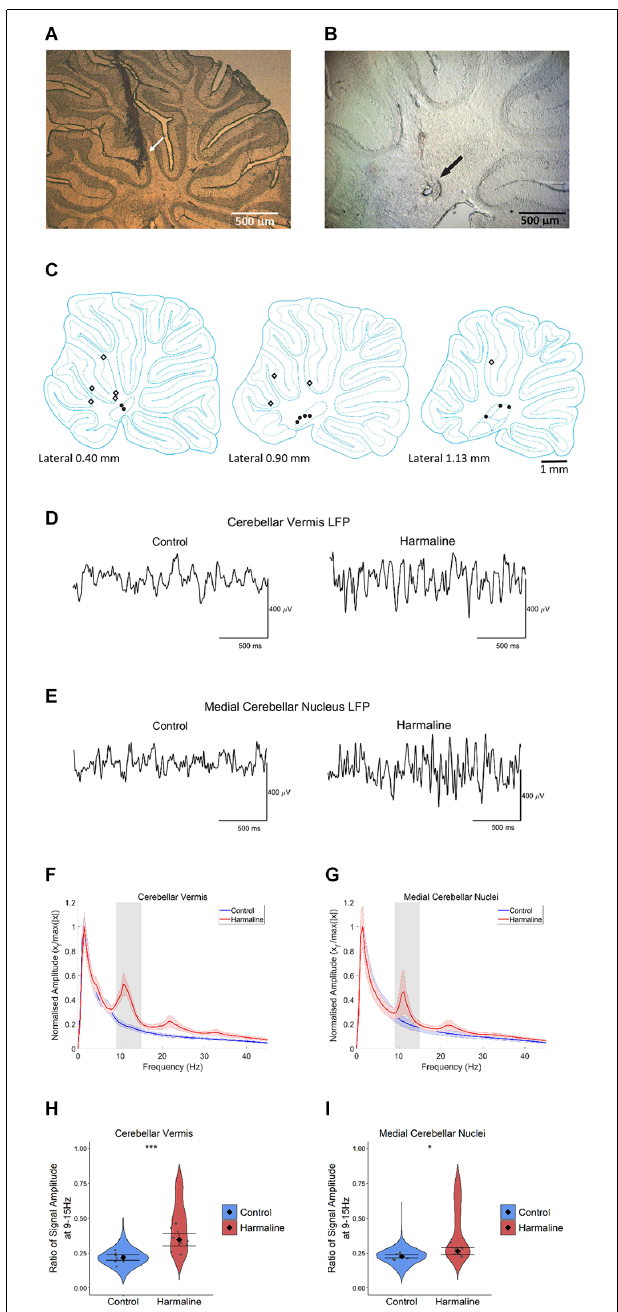
FIGURE 2 | Harmaline increases oscillatory activity in the cerebellum at the tremor frequency. (A,B) Examples of sagittal cerebellar sections with tetrode tracts in the (A) cerebellar vermis and (B) medial cerebellar nuclei from two different rats. Arrows indicate the approximate positions of the tetrode tips. (C) Summary diagram illustrating approximate electrode positions on sagittal sections of the cerebellum (adapted from Paxinos and Watson, 2005). Black dots represent approximate electrode positioning per rat in the medial cerebellar nuclei, and diamond symbols represent approximate electrode positions per rat in the cerebellar cortex. (D,E) Representative LFP traces from (D) cerebellar vermis and (E) medial cerebellar nuclei during pre-harmaline control and harmaline. (F,G) Mean ( ± SE) amplitude spectrum ( Continued )